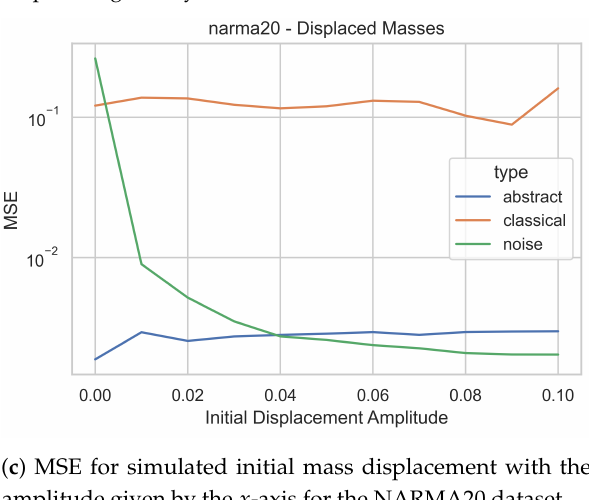
Figure 11. The average MSE with standard deviations for simulated initial mass displacements for the datasets ( a ) Hénon, ( b ) NARMA10 and ( c ) NARMA20